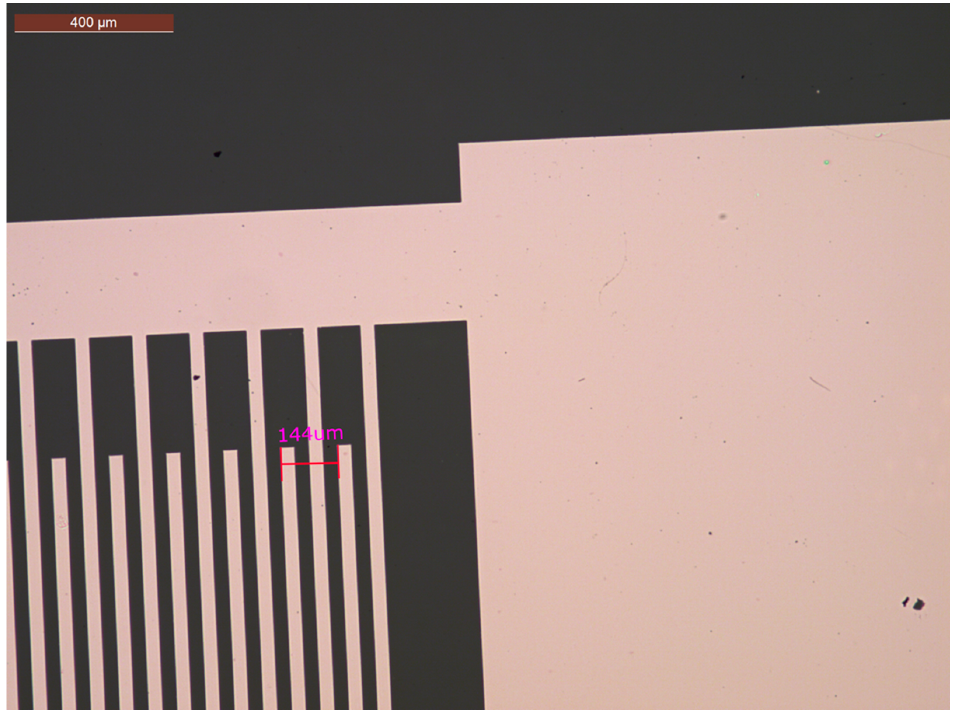
Figure 5. Micrograph of fabricated IDTs close to the metallization region between IDTs.